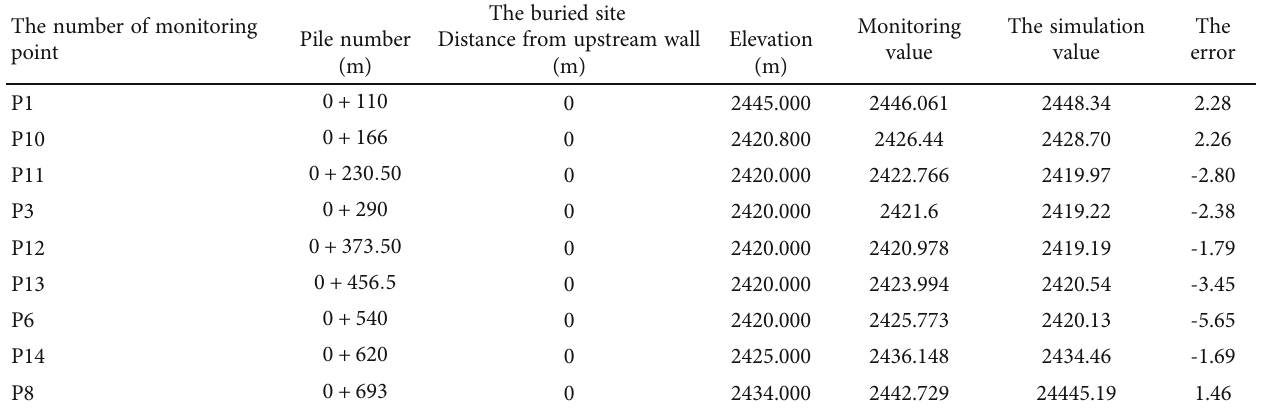
Table 3: The comparison of seepage pressure at the downstream of core base.